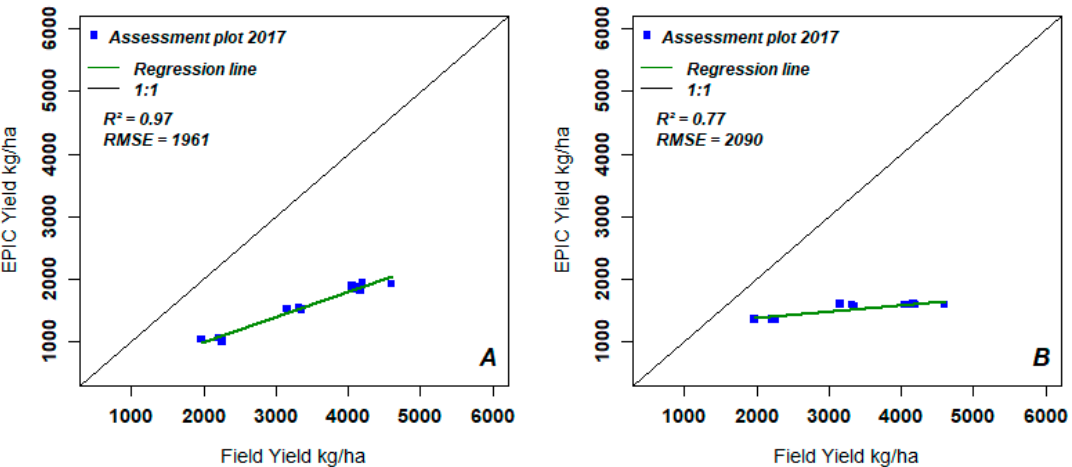
Figure 8. Comparison between ( A ) yield estimated with the assimilation of LAI from Sentinel-2 and ( B ) yield obtained with default EPIC parameters for 2017. The green line represents the regression line between the values.